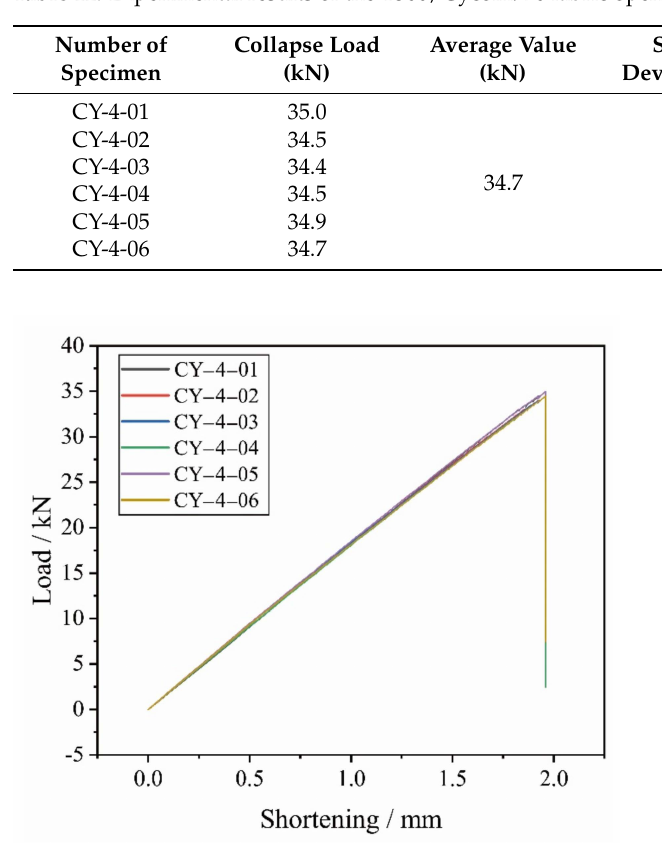
Figure 14. Experimental load-shortening curves of the